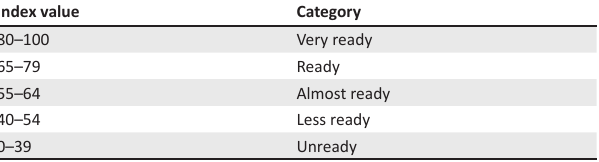
TABLE 2: Classification of preparedness levels.